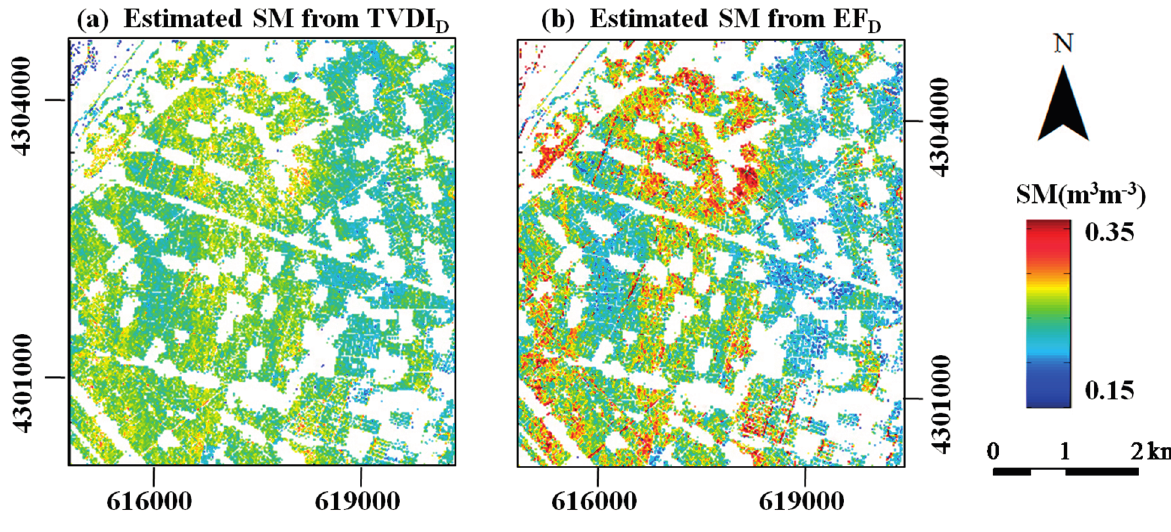
Figure 10. SM estimation in the validation